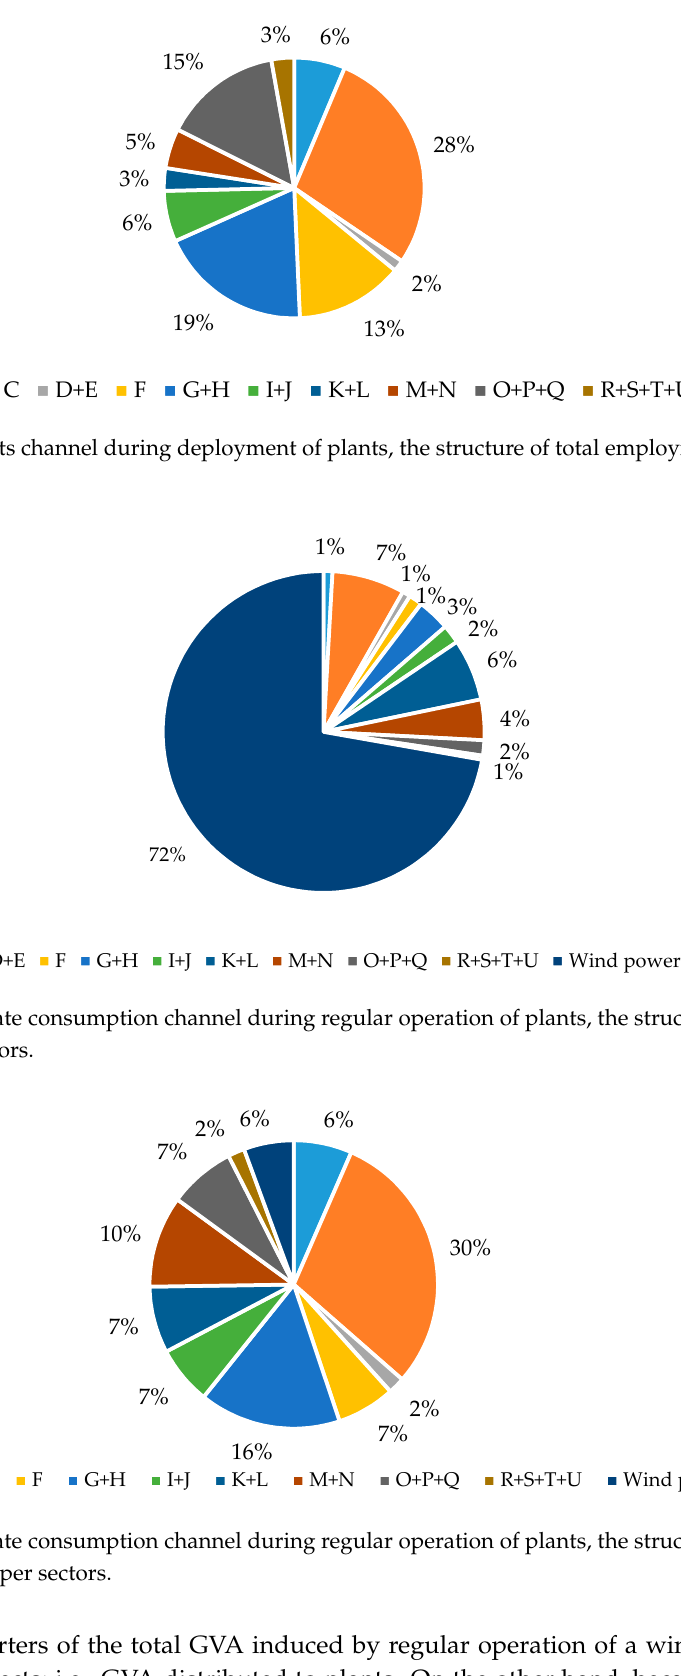
Figure 3. Investments channel during deployment of plants, the structure of total GVA effects per sectors.